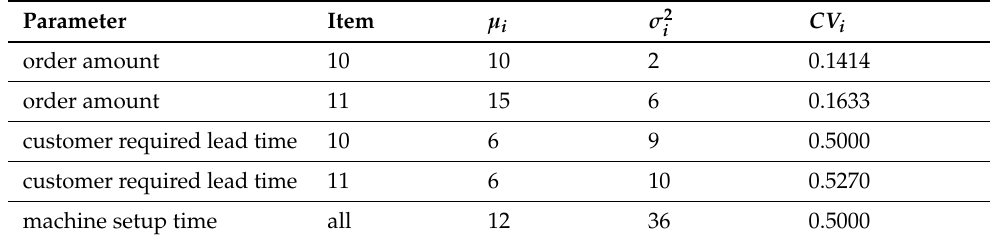
Table 2. Random variables with log-normal